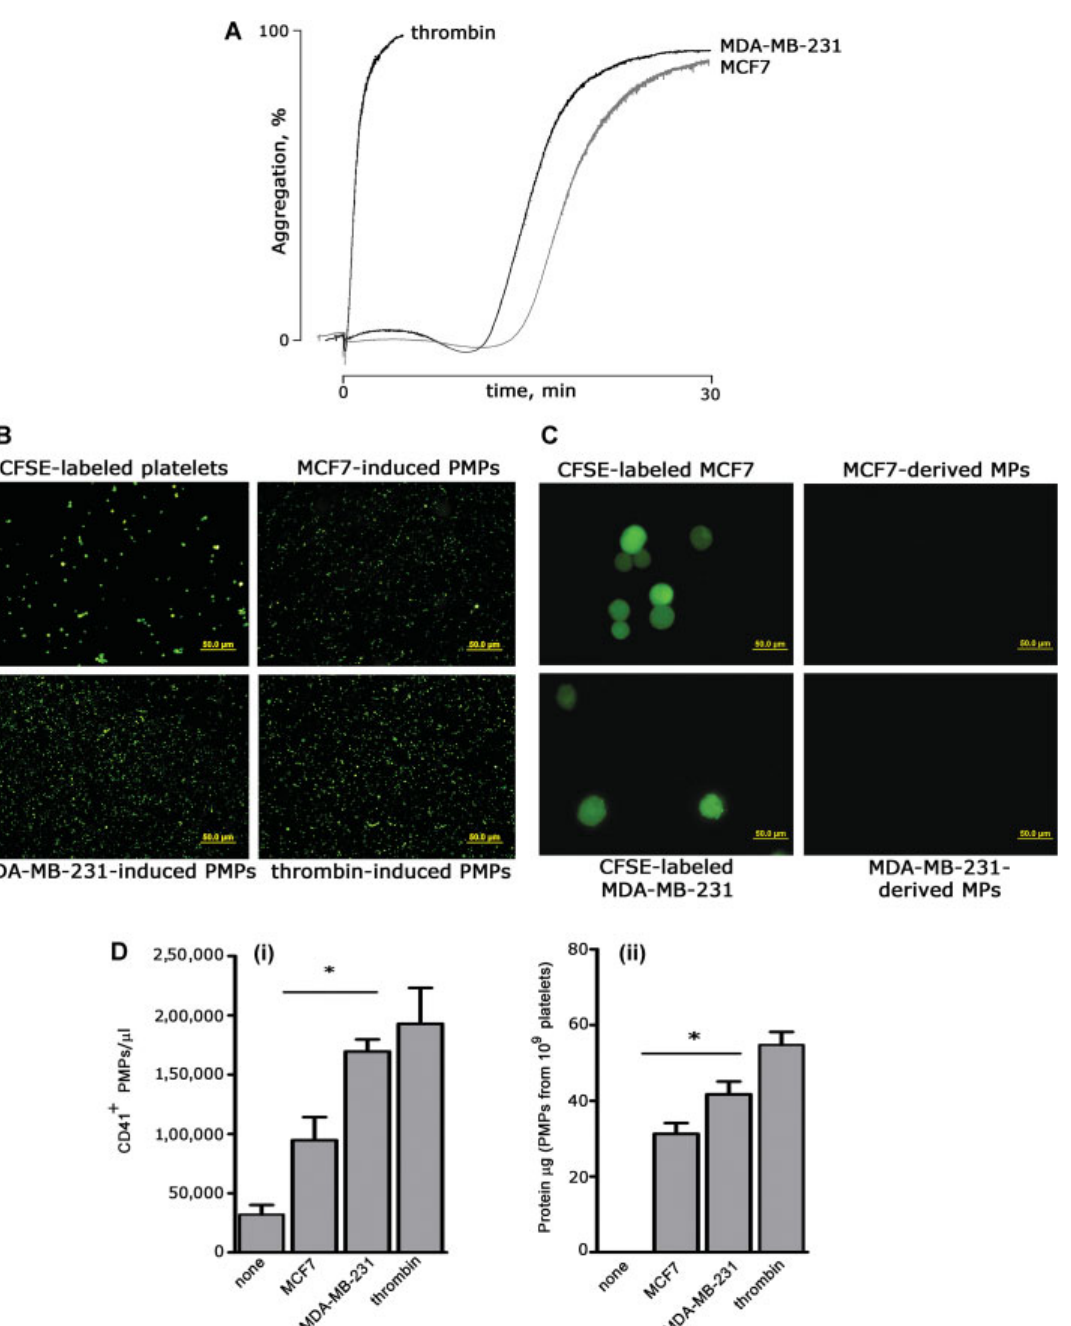
Fig. 1 Breast cancer cells induce the release of platelet-derived microparticles (PMPs). ( A ) Washed human platelets (0.3 (cid:3) 10 9 platelets/mL) were incubated for 30 minutes at 37°C under constant magnetic stirring with 5 (cid:3) 10 4 /mL of either MCF7 or MDA-MB-231 cells. Thrombin was used at 0.2 U/mL. Representative aggregation traces are reported. ( B ) PMPs release in the supernatant. Platelets were labeled with 3 µg/mL of carboxy fl uorescein succinimidyl ester (CFSE) and co-cultured with either MCF7 or MDA-MB-231 cells or stimulated with thrombin for 30 minutes at 37°C under stirring. Upon centrifugation, to remove platelets and cells, labeled PMPs in the supernatant were visualized by fl uorescence microscopy. Representative images of labeled platelets and released PMPs are reported. Scale bars: 50 µm. ( C ) Platelets do not cause the release of breast cancer cell – derived microparticles. Experiments were performed as those in panel B, except that MCF7 and MDA-MB-231 cells were labeled with CFSE before being co-cultured with unlabeled platelets. Scale bars: 50 µm. ( D ) Quanti fi cation of PMPs released by platelet stimulation with MCF7, MDA-MB-231, or thrombin. (i) PMPs were quanti fi ed using a three laser-equipped BC Navios fl ow cytometer (Beckman Coulter), upon staining with PE-labeled anti-CD41 antibody (Bio Legend). The instrument was set using Megamix-Plus (BioCytex, Marseille, France) fl uorescent calibrated beads (0.1 – 0.9 μ m range). Data were analyzed with the FCS Express 6.0 software (De Novo Software), and are reported as mean (cid:4) SEM ( n ¼ 3). (cid:1) p < 0.05. (ii) PMPs in the supernatants were recovered by centrifugation at 20,000 g for 90 minutes, resuspended in HEPES buffer, and analyzed by BCA protein assay. Results report the protein content of PMPs released from the same number of stimulated platelets (10 9 ) and are mean (cid:4) SEM ( n ¼ 7). (cid:1) p < 0.05.